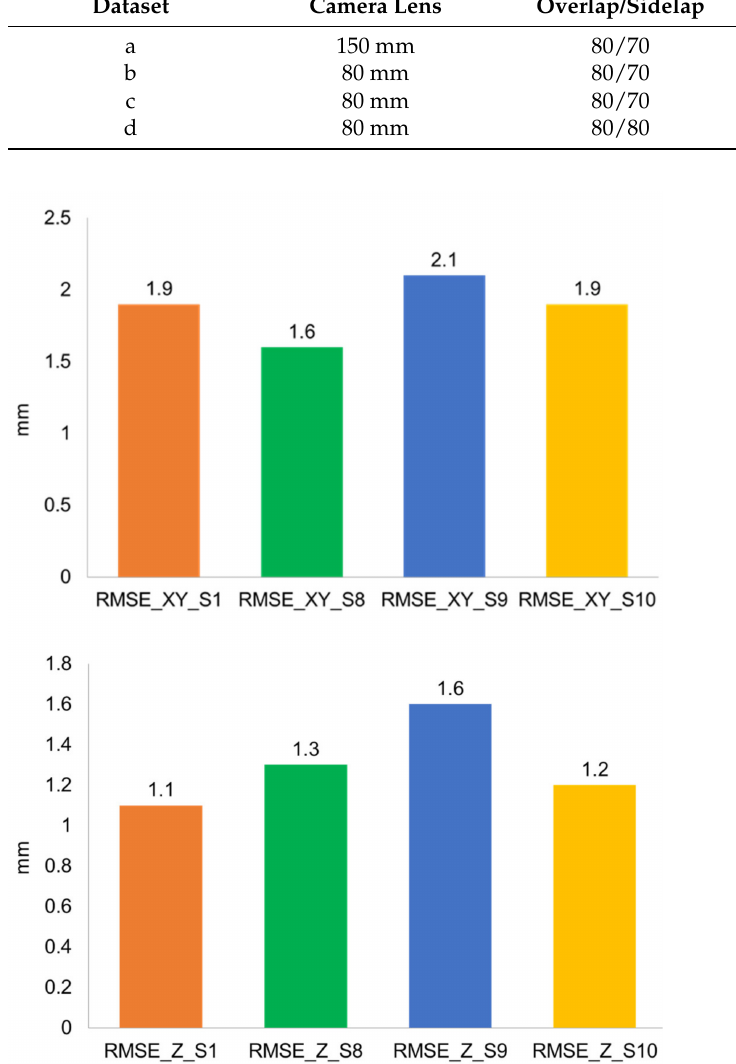
Figure 13. The RMSE of the position ( top ) and height ( bottom ) deviation for each survey.